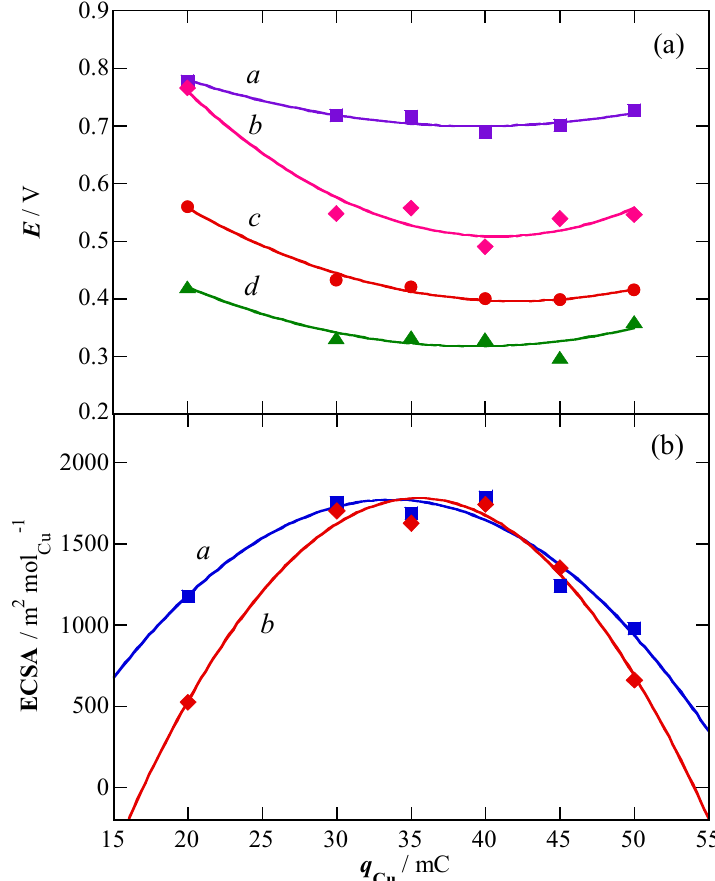
Figure 2. ( a ) Peak potentials for CO oxidation on Pt(Cu)/C (curve a ) and on Pt ‐ Ru(Cu)/C (curve b ), and onset potentials for CO (curve c ) and methanol oxidation (curve d ) on Pt ‐ Ru(Cu)/C, as a function of the electrodeposition charge q Cu ; ( b ) Dependence of the electrochemical surface area (ECSA) for CO oxidation on q Cu for Pt(Cu)/C (curve a ) and for Pt ‐ Ru(Cu)/C (curve b ). The electrocatalysts were prepared according to sequence i .